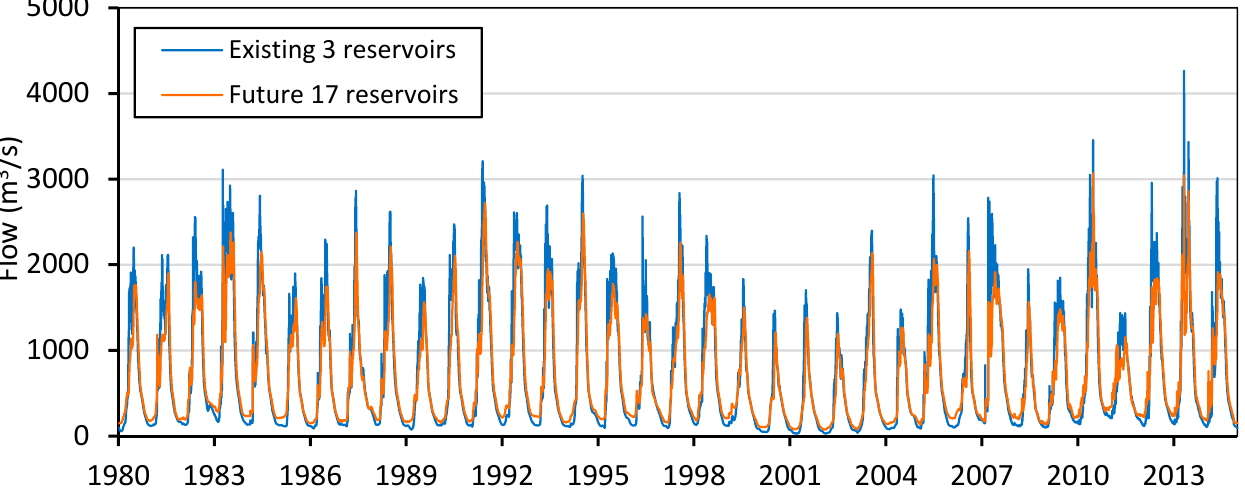
Figure 4. Simulated daily flow at the outlet of KRB (Afghanistan) with and without future dams.